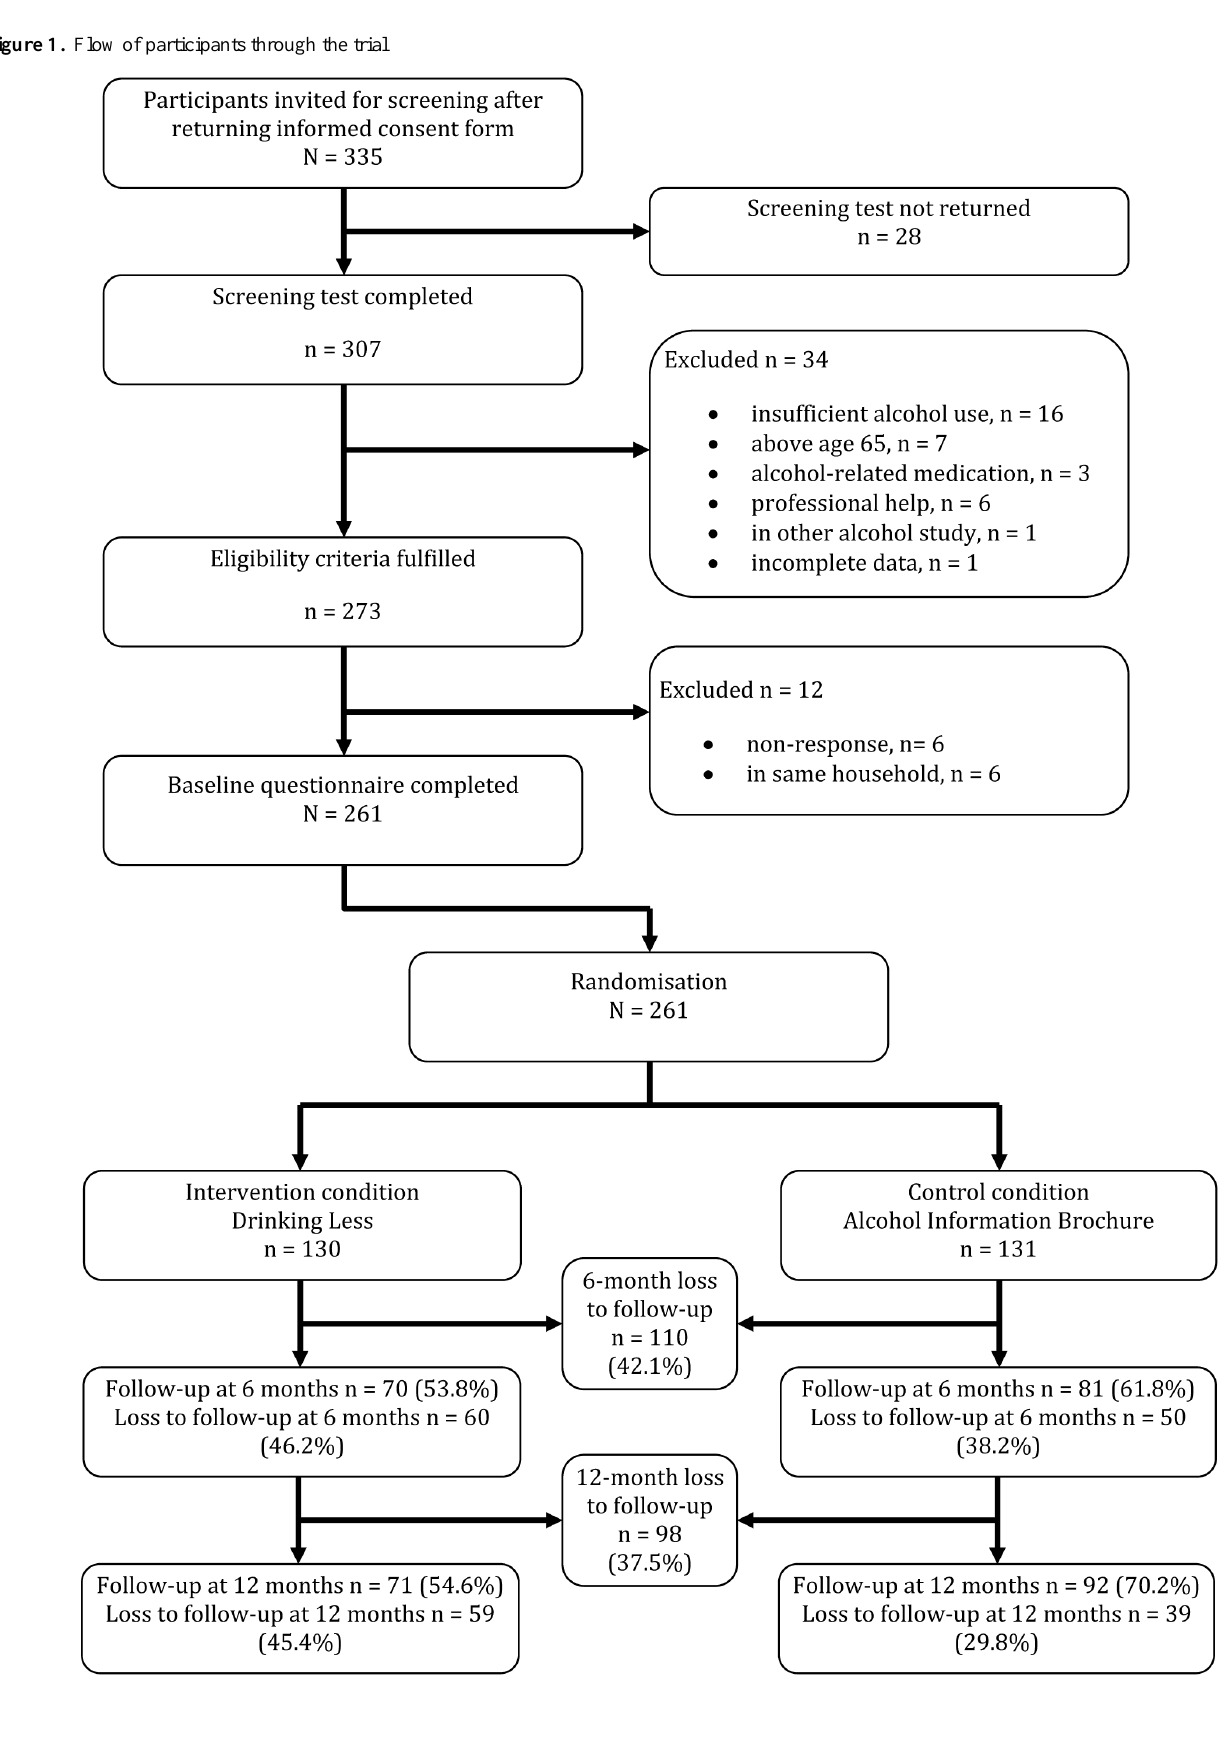
Figure 1. Flow of participants through the